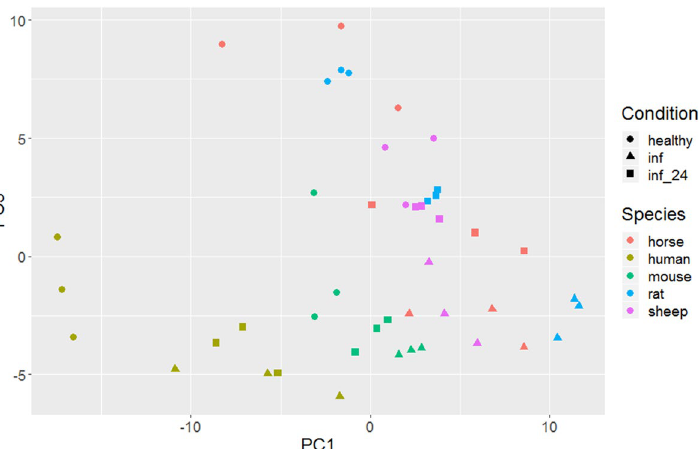
Figure 5. Plot of PC1 (explaining 36% of the variance) vs. PC3 (explaining 14% of the variance) of a Principal Component Analysis of gene expression values. Species are colour coded, conditions (healthy, transiently inflamed, and continuously inflamed) are differentiated by symbols. Each dot represents a different biological